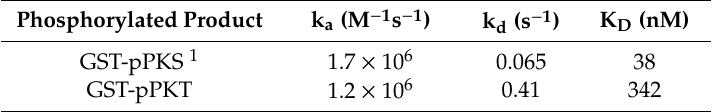
Figure 2. Phosphorylation of the threonine substrate PKT. ( A ) On-chip phosphorylation of GST-PKS (red) and GST-PKT (black) with 100 nM PKA Cα wt (Figure S2). On-chip phosphorylation of GST-PKT is faster than phosphorylation of GST-PKS. Equal amounts of GST-PKS and GST-PKT were immobilized to two parallel flow cells to analyze on-chip phosphorylation by PKA Cα simultaneously. ( B ) Radioactive kinase assay. Substrate phosphorylation with radioactively labeled γ - 32 P-phosphate was measured over time. Data were plotted as means of two independent protein preparations that were each measured in duplicate with standard deviation (SD). Phosphorylation of GST-PKT (black) was twice as fast as phosphorylation of GST-PKS (red). ( C ) SPR analysis of the product complex with immobilized GST-pPKT in the presence of 0.2 mM ADP and 1 mM MgCl 2 . See Table 2 for kinetic data. Table 2. Comparison of the product dissociation of phosphorylated GST-pPKS and GST-pPKT. Kinetic data derived from SPR analyses in the presence of 0.2 mM ADP and 1 mM MgCl 2